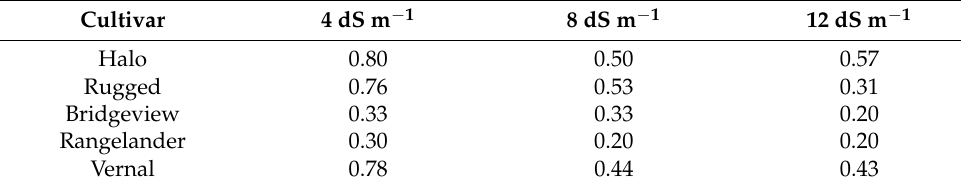
Table 2. Salt tolerance index of alfalfa cultivars based on shoot biomass yield.